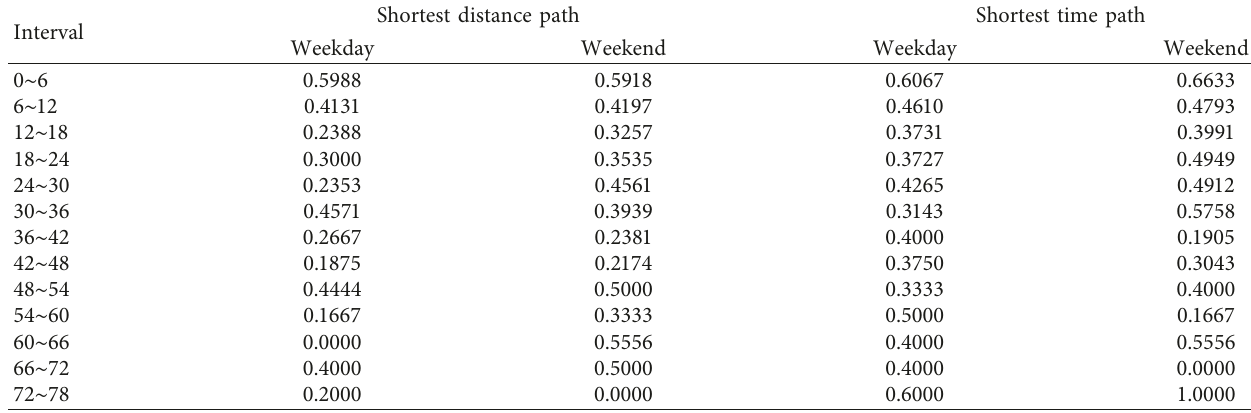
Table 15: Segment selection of different distance intervals for the shortest